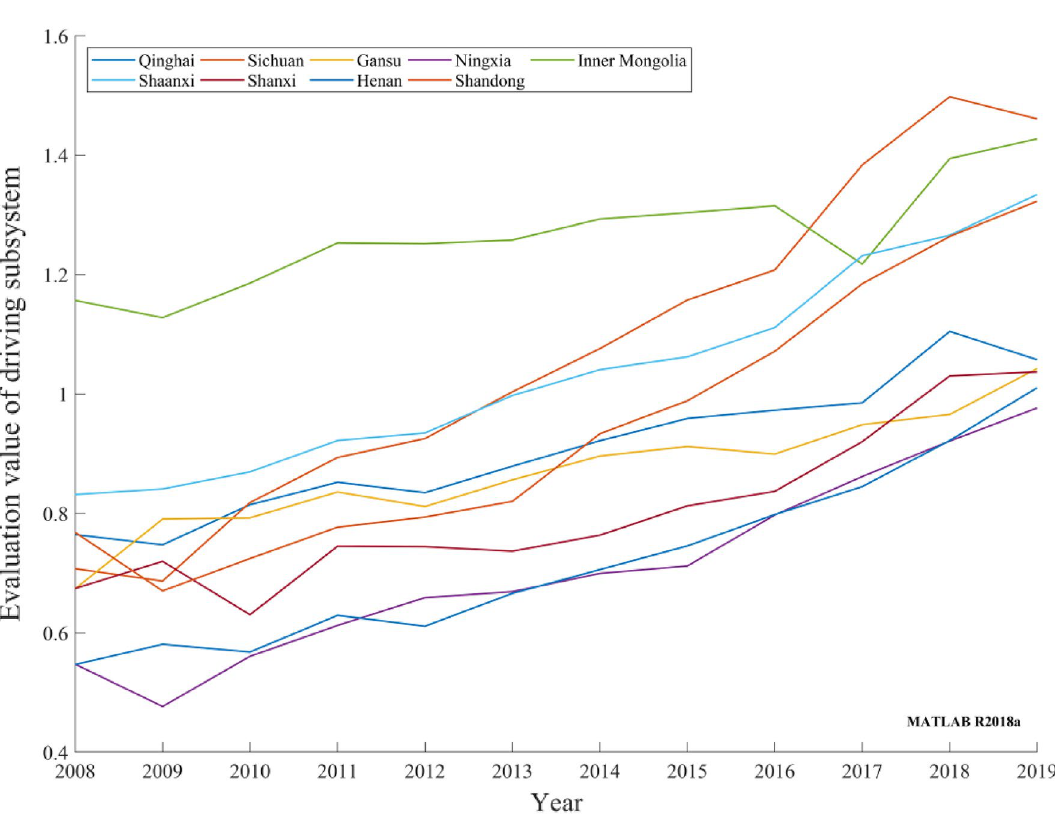
Figure 3. Evaluation values of provincial carbon-neutral driving subsystems in the Yellow River basin during